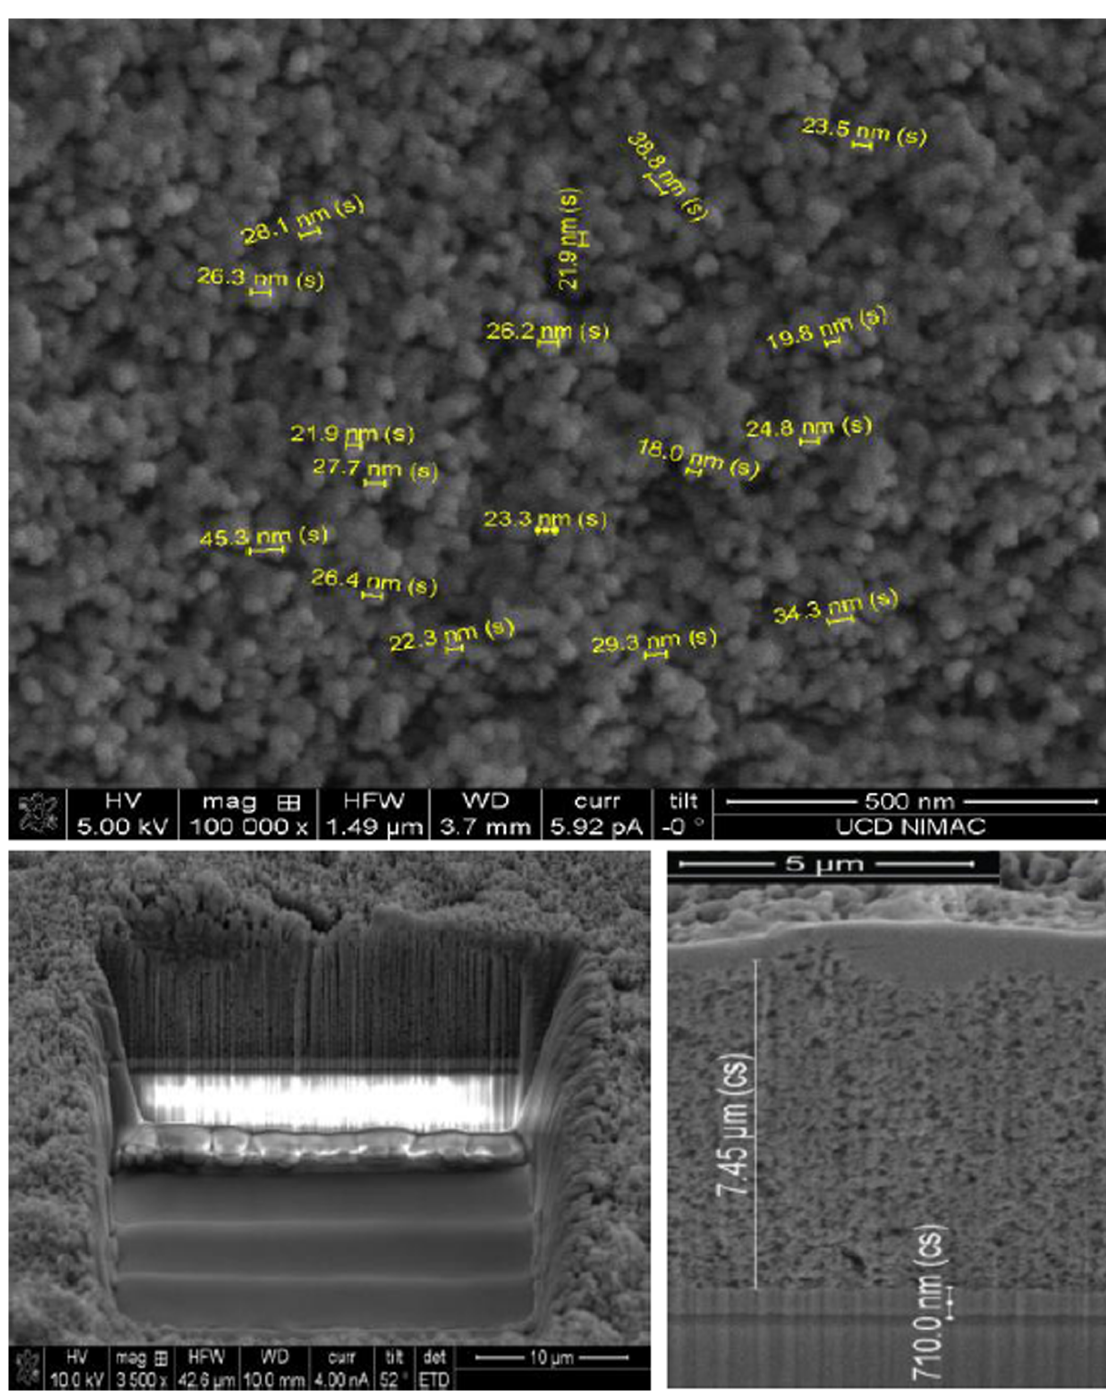
Figure 2. SEM and FIB imaging analysis revealed the average dimensions of the TiO 2 layer and of the TiO 2 nanoparticles. a) (top) The TiO 2 nanoparticle average diameter 24 nm; b) (bottom left) FIB milling was used to remove a cuboid with dimensions of 20 m m 6 30 m m 6 20 m m; c) (bottom right) The FTO initial (pre-sintering) thickness 710 nm (averaged